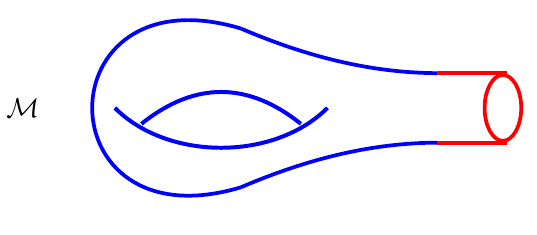
Figure 1 . Manifold M with a collar N (cid:2) I shown in